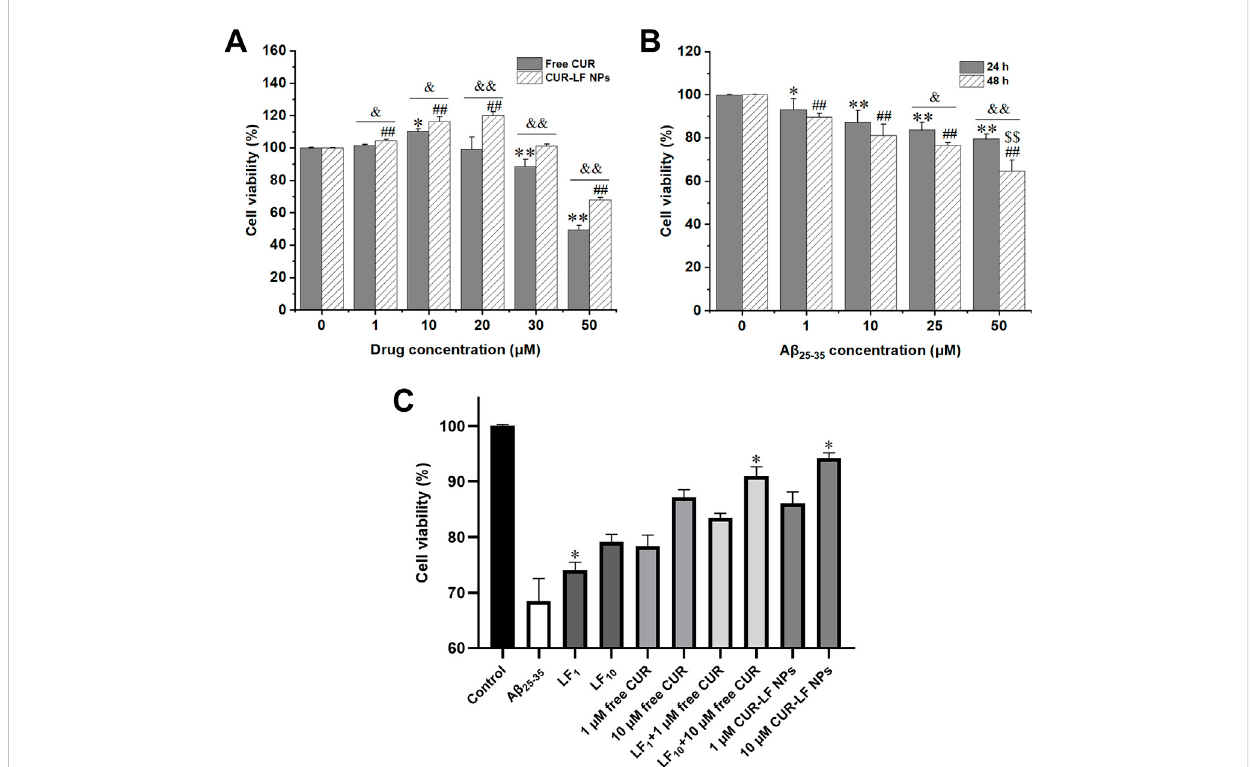
FIGURE 5 Cell viability assay (A) PC12 cells treated with free curcumin and CUR-LF NPs (1, 10, 20, 30, and 50 μ M) for 24 h * p < 0.05, ** p < 0.01 free curcumin group versus solvent control group; # p < 0.05, ## p < 0.01 CUR-LF NPs group versus solvent control group; & p < 0.05, && p < 0.01 free curcumin group versus CUR-LFNPsgroup (B) Investigationofinductionconcentration(1,10,25,and50 μ M)andtime(24and48 h)ofA β 25-35 -inducedPC12celldamage. * p < 0.05, ** p < 0.01 A β 25-35 group versus control group at 24 h induction time; # p < 0.05, ## p < 0.01 A β 25-35 group versus control group at 48 h induction time; & p < 0.05, && p < 0.01 24 h versus 48 h induction time; $ p < 0.01, $$ p < 0.01 indicating the induction concentration and time was signi fi cantly different from other groups (C) Protective effect of lactoferrin nanoparticles, free curcumin, lactoferrin nanoparticles + free curcumin,